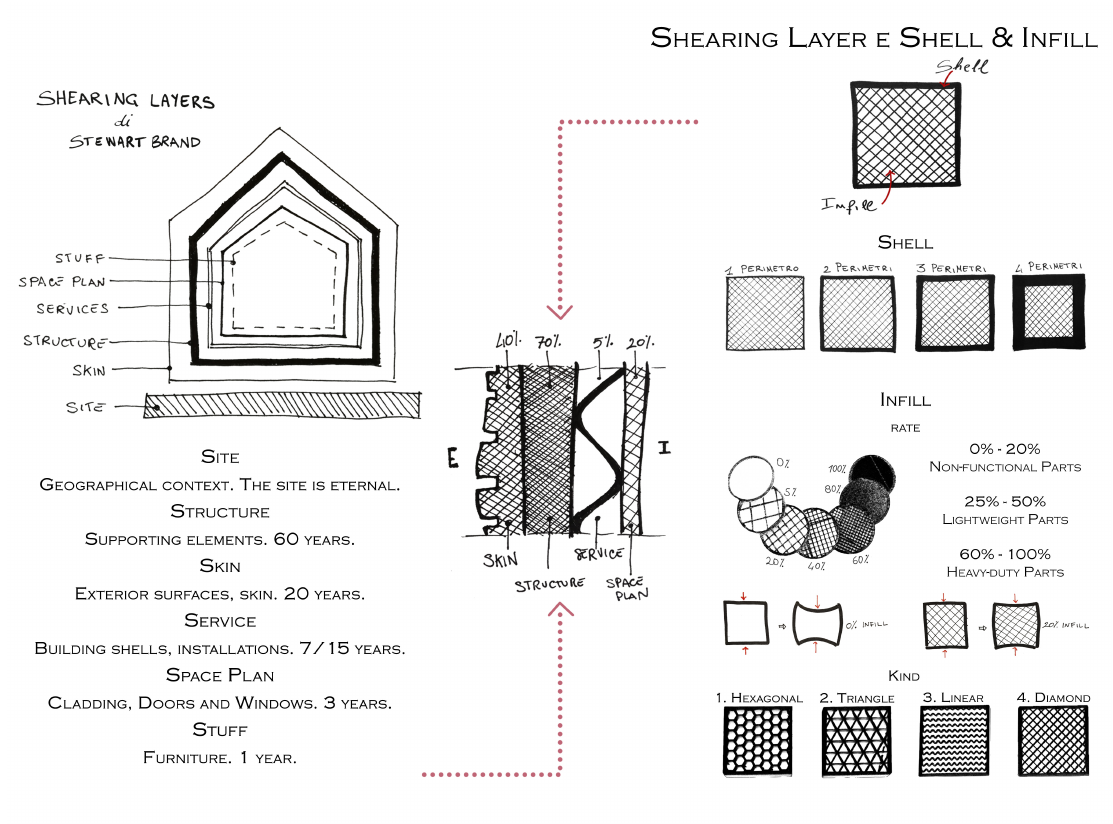
Figure 5. Stuart Brand’s six-layer model applied to the ’Shell&Infill’ principle of 3D